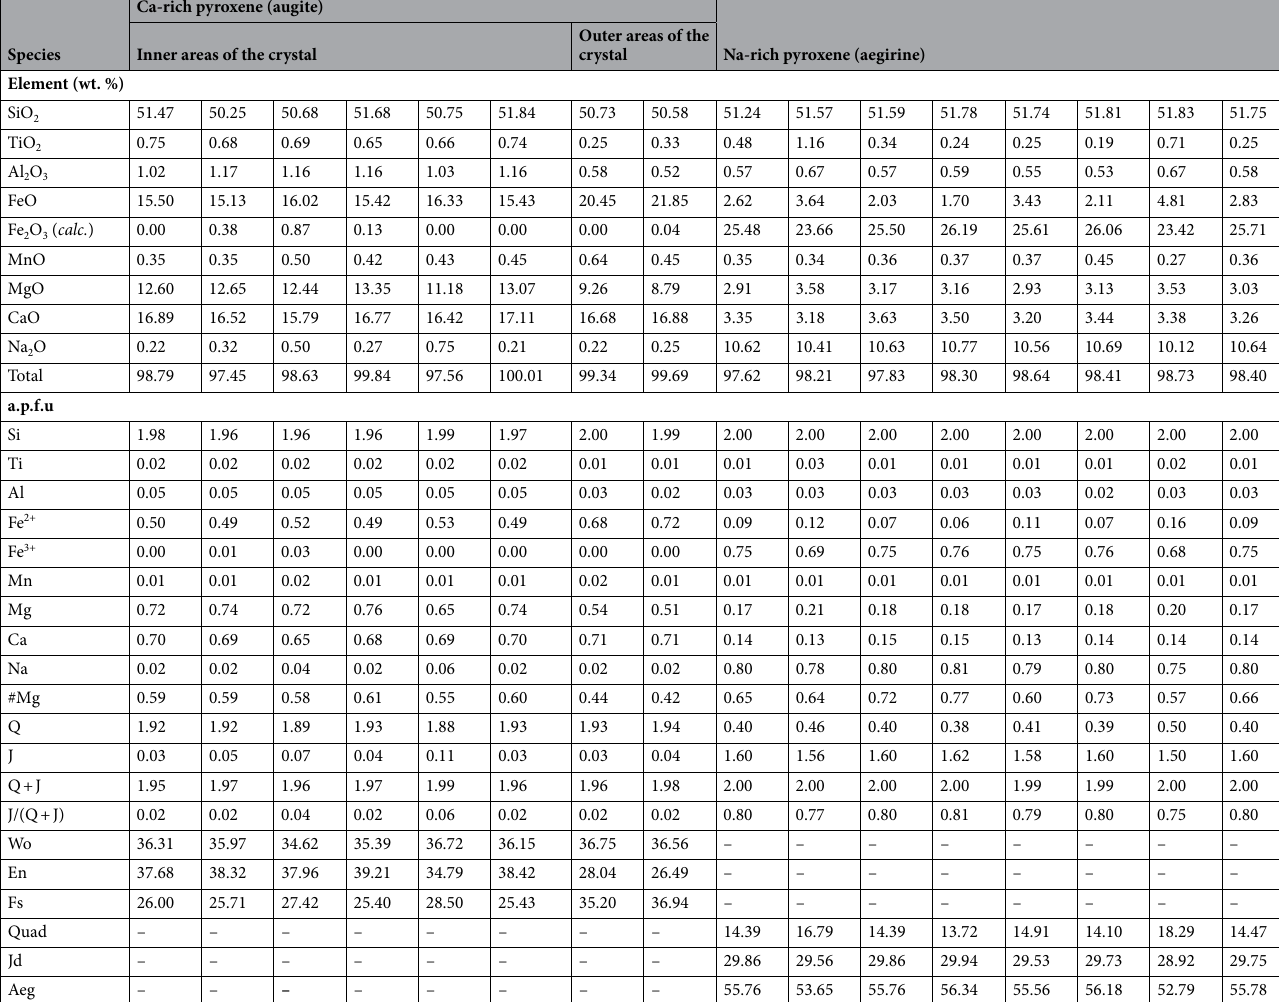
Table 2. Representative clinopyroxene (aegirine and augite) compositions (EMPA) from the samples collected from lower parts of the exposure (Loc. 1) (based on 6 oxygen atoms). Note: #Mg = 100 Mg/(Mg + Fe 2+ ); Fe 3+ calculated from charge balance; Q = Ca + Mg + Fe 2+ ; J = 2Na.